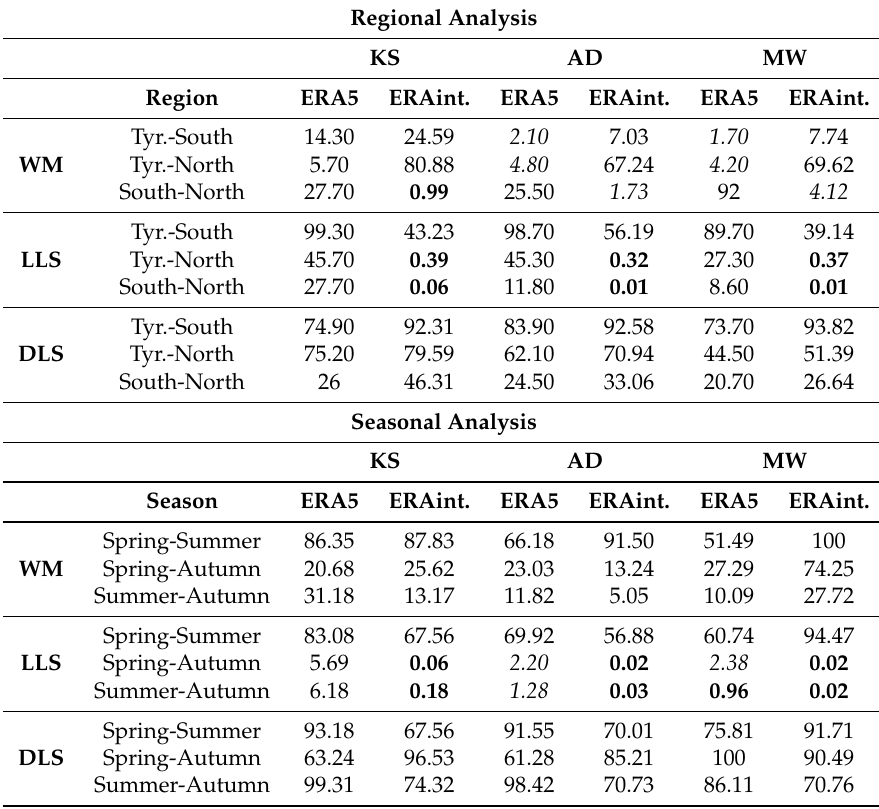
Table 2. Statistical comparison of the samples of WM, LLS, and DLS collected in different regions and seasons: both ERA-5 and ERA-Interim reanalyses are considered. Shown are the p -values (in %) of (i) the KS and AD two-sample homogeneity tests (the Null assumption is that the distributions of the samples are statistically compatible), and (ii) the MW central tendency test (the Null assumption is that it is equally likely that a randomly selected value from one population is less, or greater, than a randomly selected value from a second population). Values in bold are smaller than 1%, while those in italic are smaller than 5%. The Null assumptions could be rejected at α -levels larger than the p -values